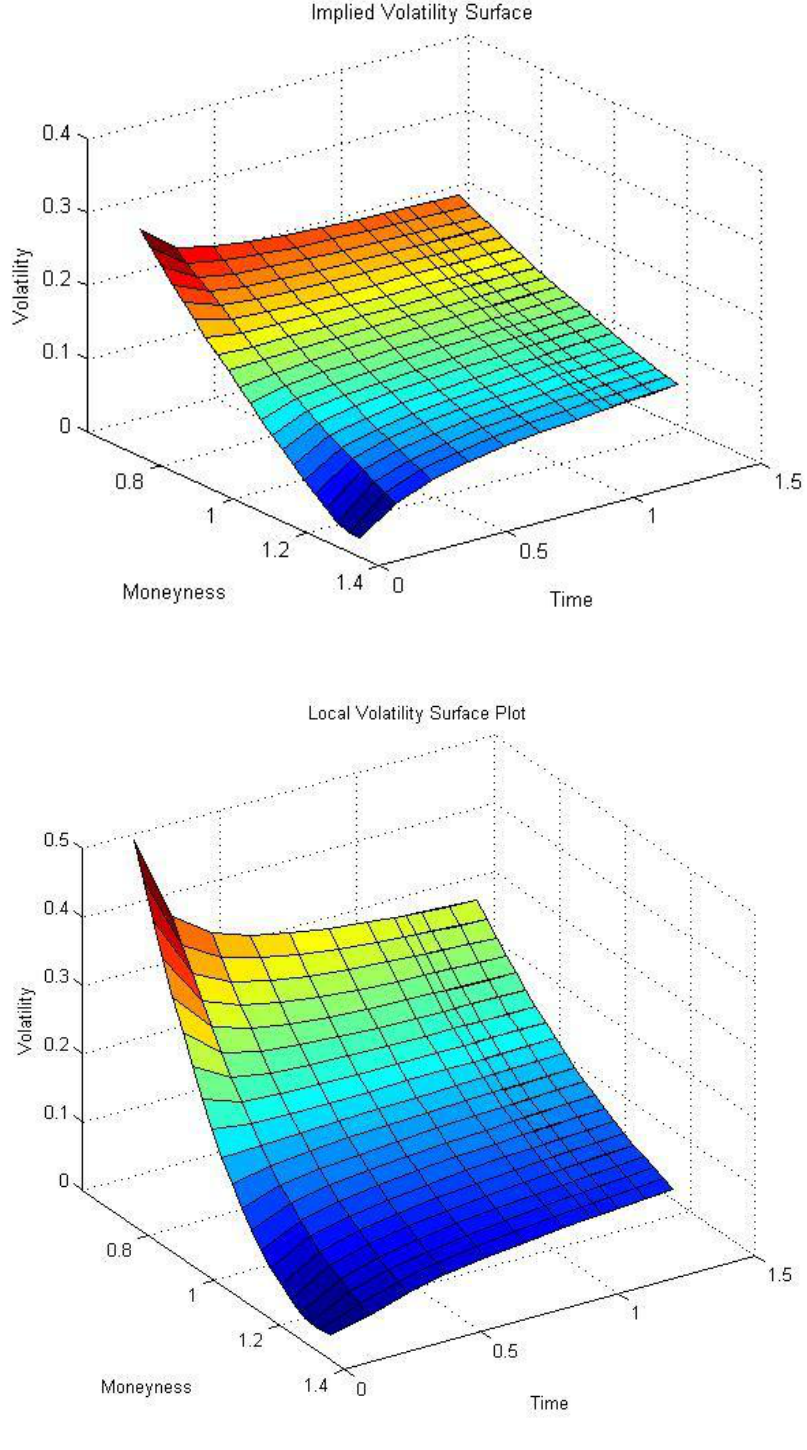
Figure 6. ALSI implied and local volatility surfaces on 28 May